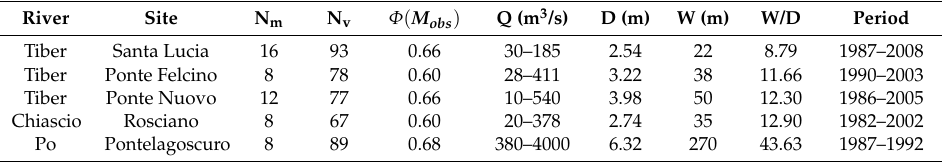
Table 1. Flow dataset characteristics: N m = number of velocity measurements considered, N v = total number of verticals (from the N m measurements), Φ ( M obs ) = observed entropy parameter, Q = measured discharge, D = average flow depth, W = average channel width. The period of sampling is also